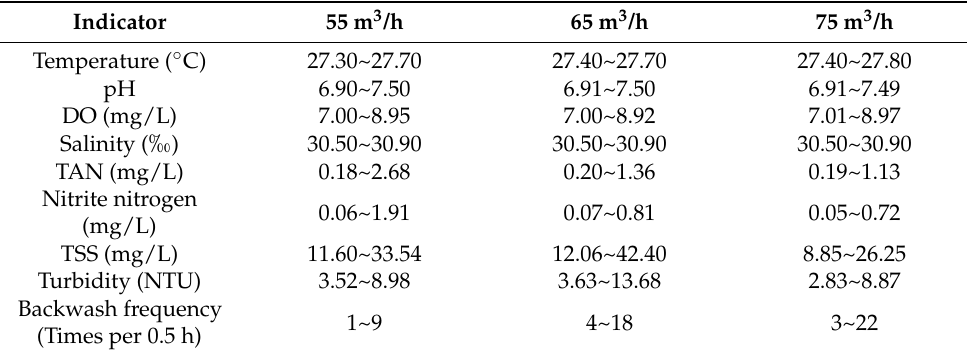
Table 1. Ranges of water quality indicators at three total circulation rate